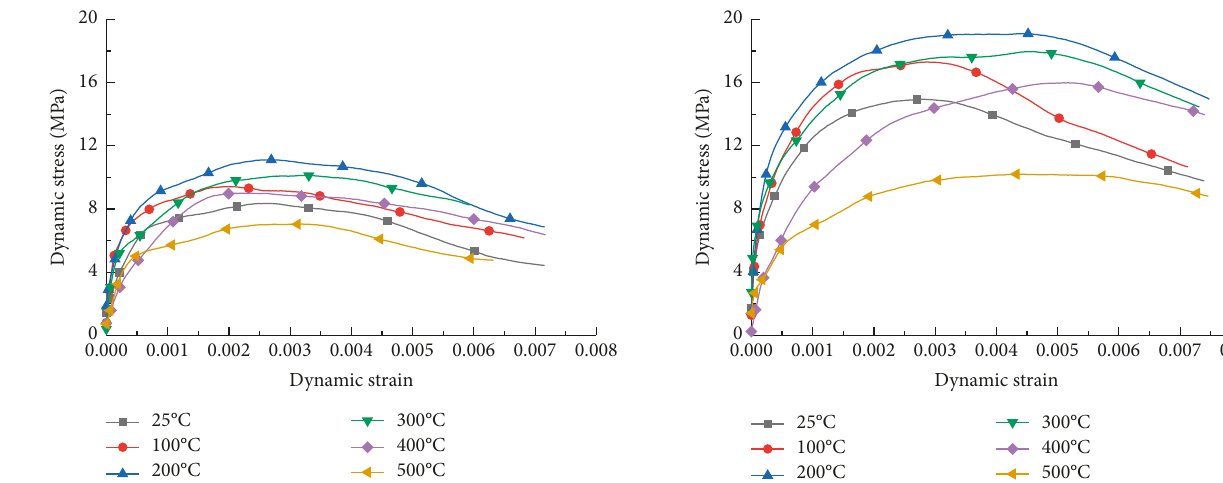
Figure 8: Dynamic splitting stress-strain curves of annular sandstone samples.